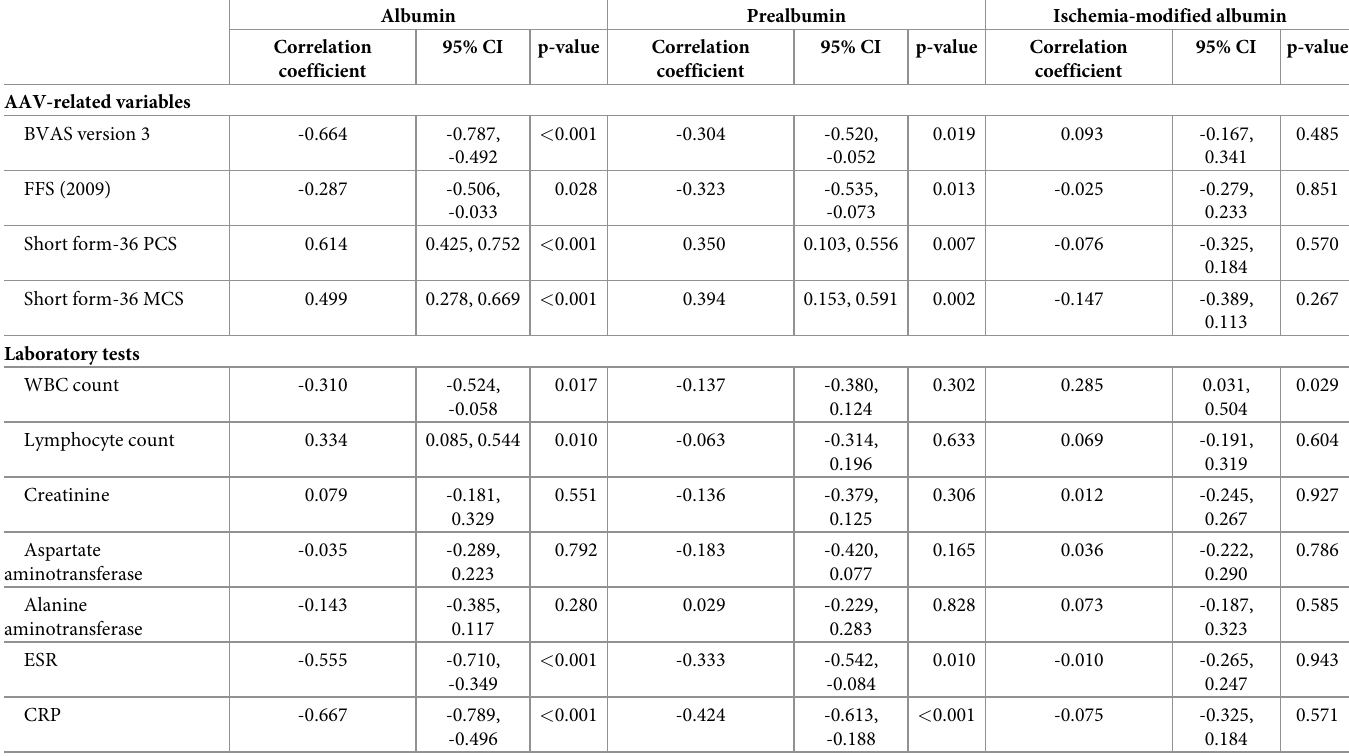
Data are shown as correlation coefficient